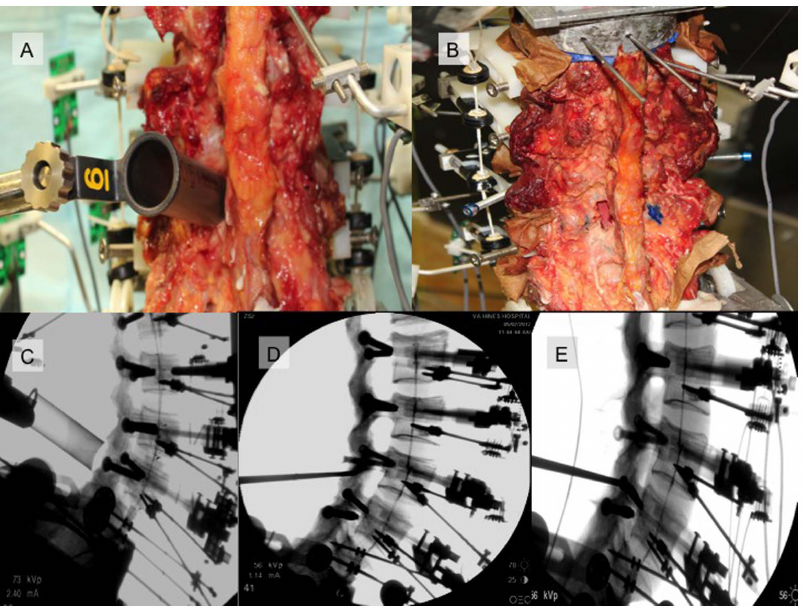
Figure 2. Images demonstrating testing of the minimally invasive surgical procedure. Unilateral docking of the METRx tube at L4/L5 is shown (A) as well as post-procedural anatomic changes following decompression (B). A radiograph demonstrating tubular docking is shown in C. Following complete removal of the ligamentum flavum and internal bony decompression, a curette was placed at the superior and inferior extent of decompression to confirm a ‘‘pedicle-to-pedicle’’ dural decompression.